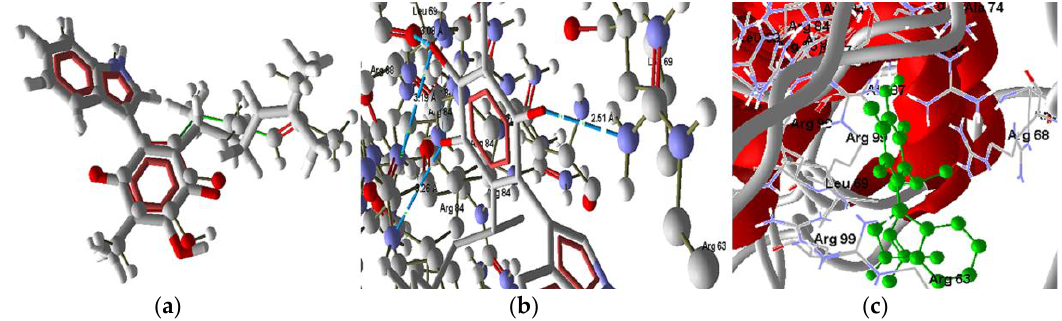
Figure 13. Model of interaction of 2 with t-BID. ( a ) Compound 2 and t-BID complex, overlapping of the ligand (red) and the pose (grey); ( b ) Interaction of 2 and t-BID complex, showing three H bonds between the carbonyl group and the protein residues; ( c ) Secondary structure, ligand (green) in the middle of the protein.